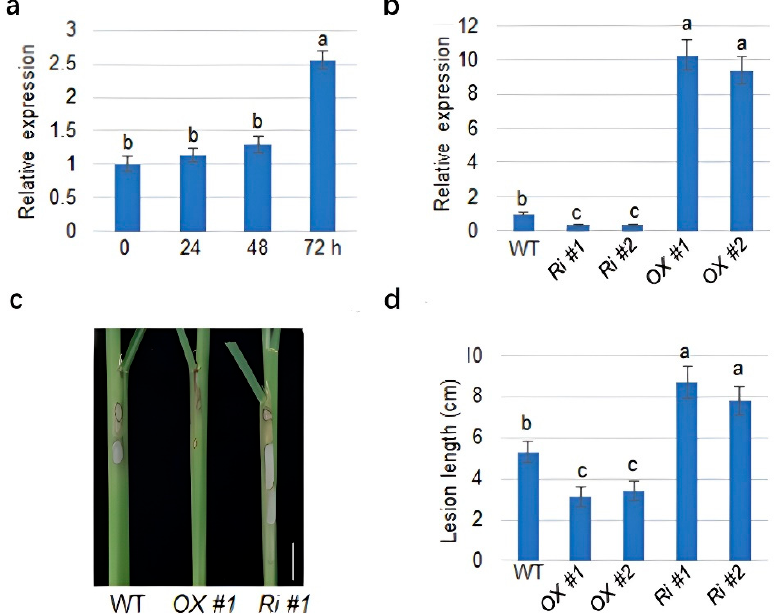
Figure 1. The regulation of MDPK to ShB resistance: ( a ) relative expression of MDPK in wild-type (WT) at 0, 24, 48, and 72 h after inoculation with R. solani AG1-IA. The error bars mean ± SE ( n = 3); ( b ) the expression level of MDPK in wild-type, MDPK RNAi ( Ri #1 , Ri #2 ), and MDPK overexpressing ( OX #1 , OX#2 ) plants. The error bars mean ± SE ( n = 3); ( c ) the response of MDPK RNAi plants ( Ri #1 ) and MDPK overexpressing plants ( OX #1 ) to R. solani AG1-IA compared with the wild-type. Each experiment was performed in triplicate; ( d ) the lesion lengths on sheath shown in ( c ) were calculated. Data indicate average ± standard error (SE) ( n > 10). Bonferroni’s multiple comparison test, was used for the calculation of comparisons between different groups. Letter a, b and c in the figure indicate significant differences at p < 0.05.